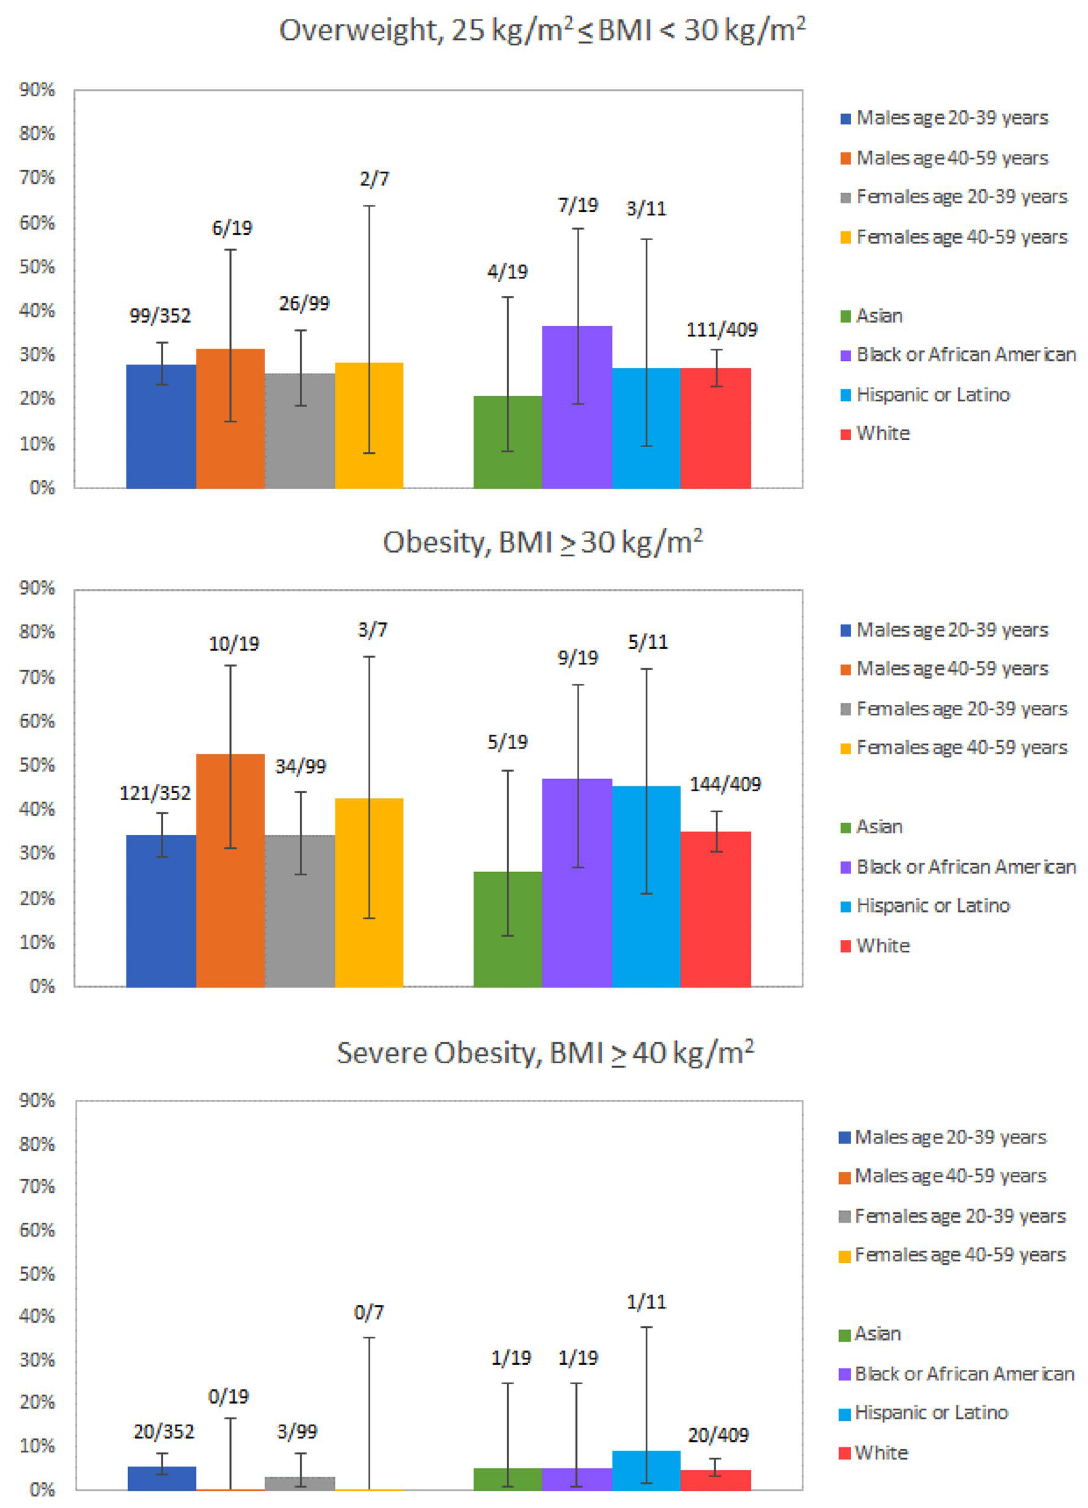
Figure 2. Sample prevalence of overweight, obesity (inclusive of severe obesity), and severe obesity in ASD patients by sex, age category (years), and race and ethnicity. Error bars correspond to the width of 95% confidence intervals for prevalence estimates. Observed frequencies are reported above error bars. Body mass index (BMI) data were missing for 5 adults: 2 males 20–39 years, 1 male 40–59 years, and 2 females 20–39 years; 3 White, 1 Hispanic or Latino, and 1 other race. Estimates are not reported for age 60 years and over because only one participant was over age 60 years. Race and ethnicity categories were taken from the patient data registry. Race and ethnicity was missing for 18 adults with BMI